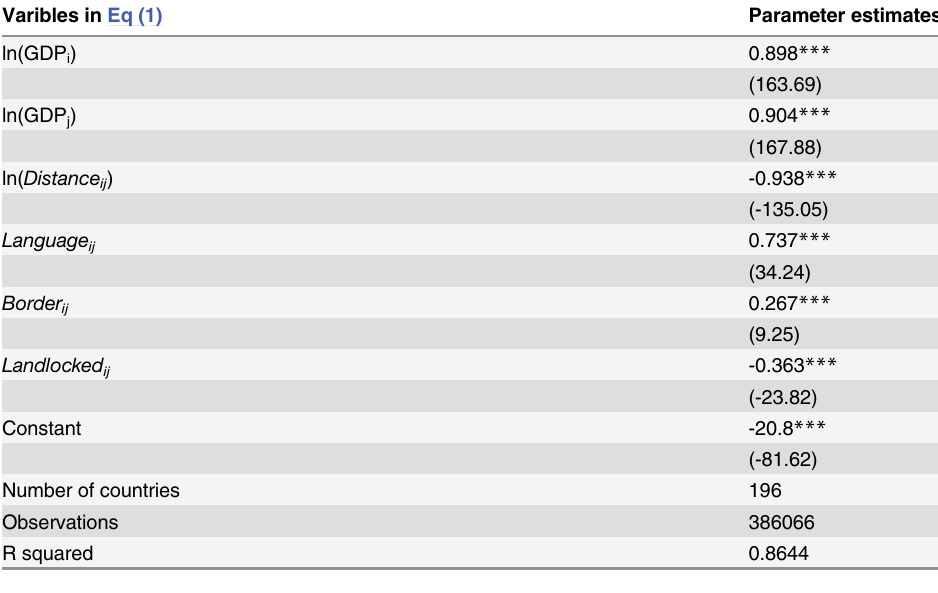
Table 2. Estimates in Trade Equation.